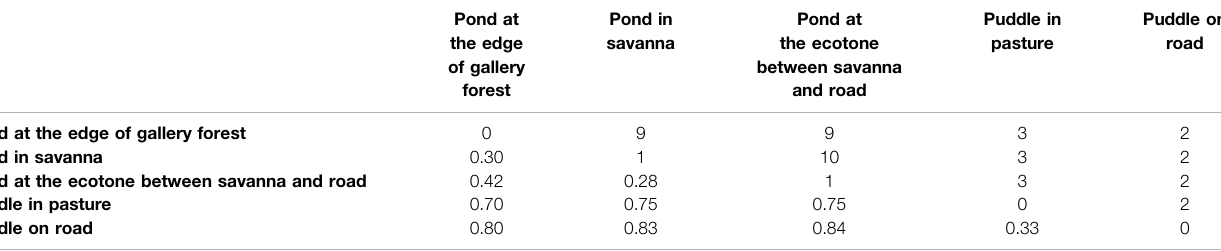
TABLE3| Complementarityofanuranspeciesinthelarvaldevelopmentalstagebetween fi vebodiesofwaterintropical fl oodedsavannaoftheYopalMunicipality(Casanare Department, Colombia) a .